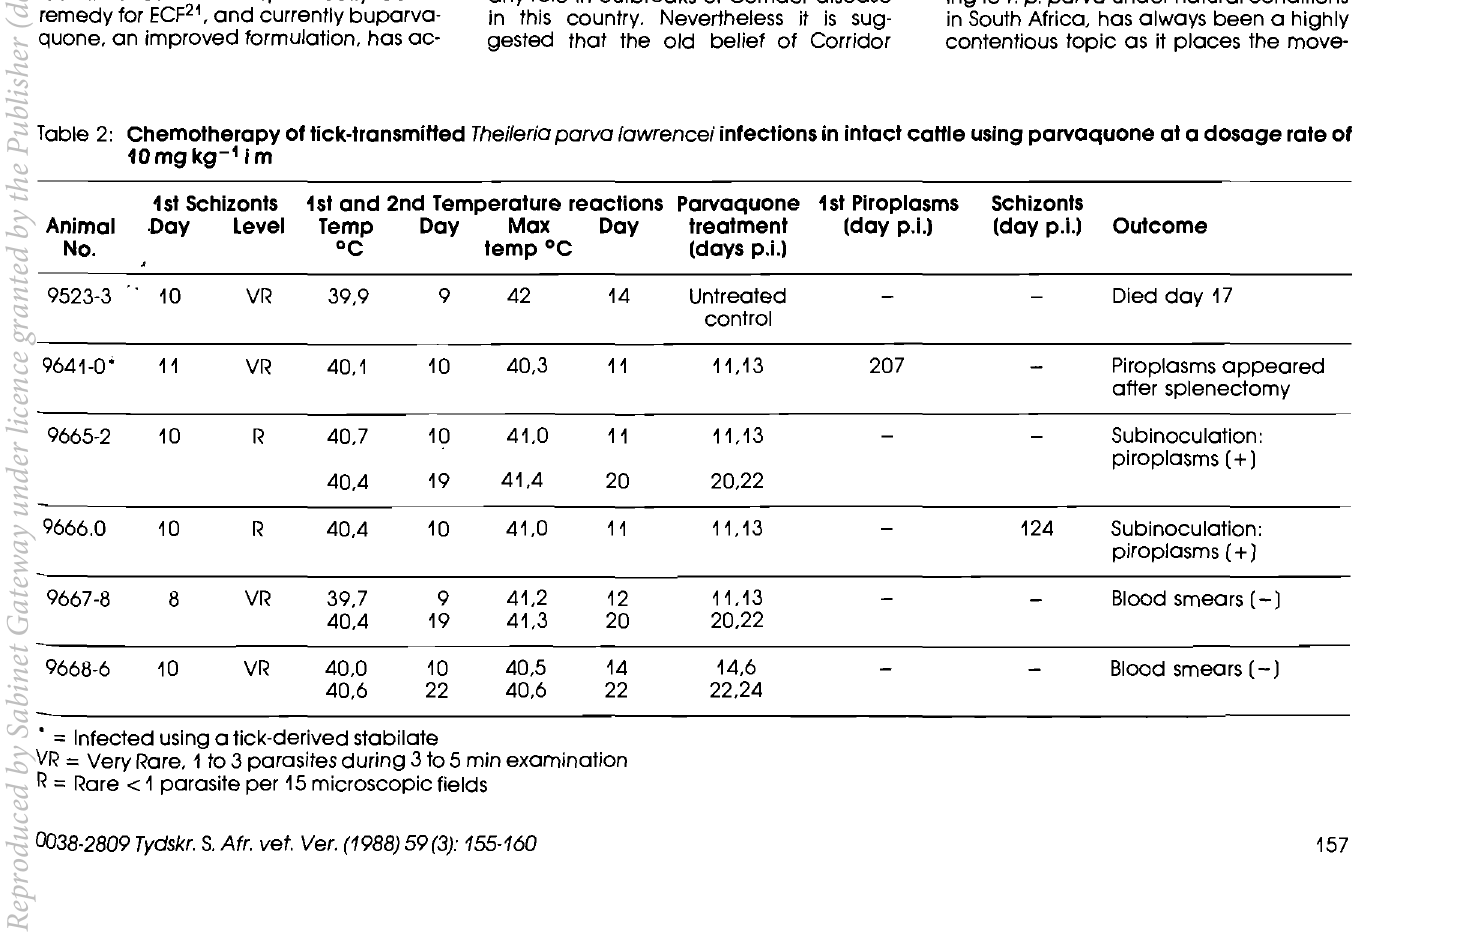
Table 2: Chemotherapy of tick-transmiHed Theileria parva lawrencei infections in intact caHle using parvaquone at a dosage rate of 10mgkg- 1 im 1 st Schizonts